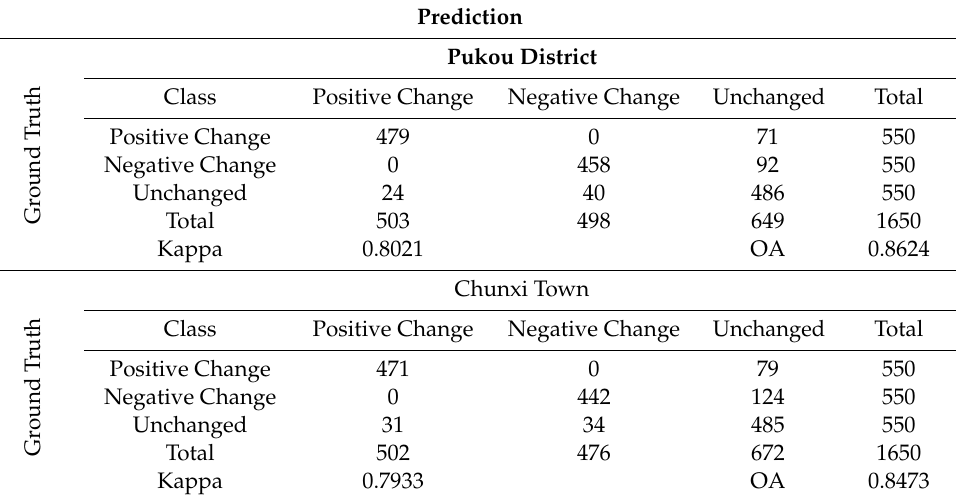
Table 4. Accuracy assessment of the results in Figure